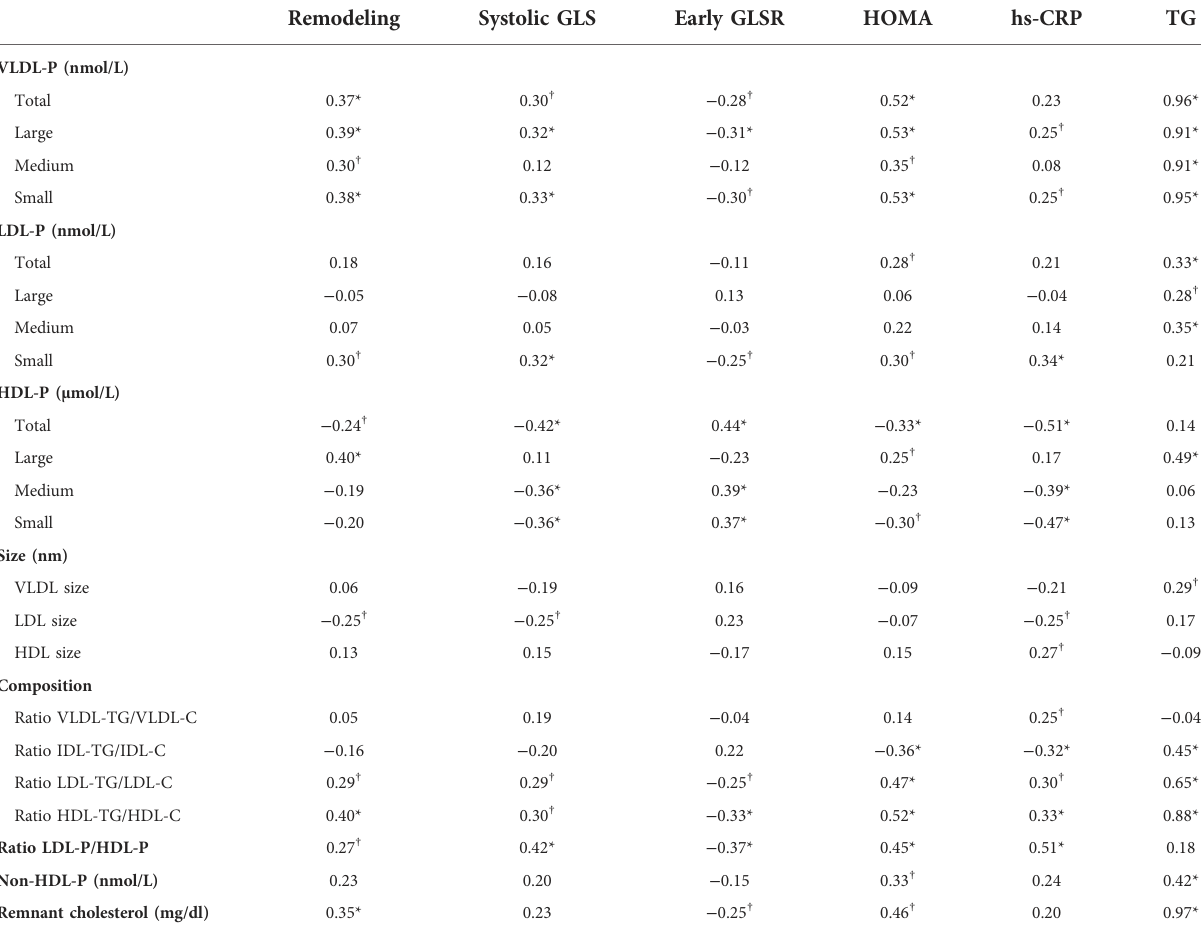
TABLE 4 Bivariate correlations between lipoprotein particles and left ventricle structural and functional parameters, insulin resistance index, in fl ammatory marker and triglycerides.